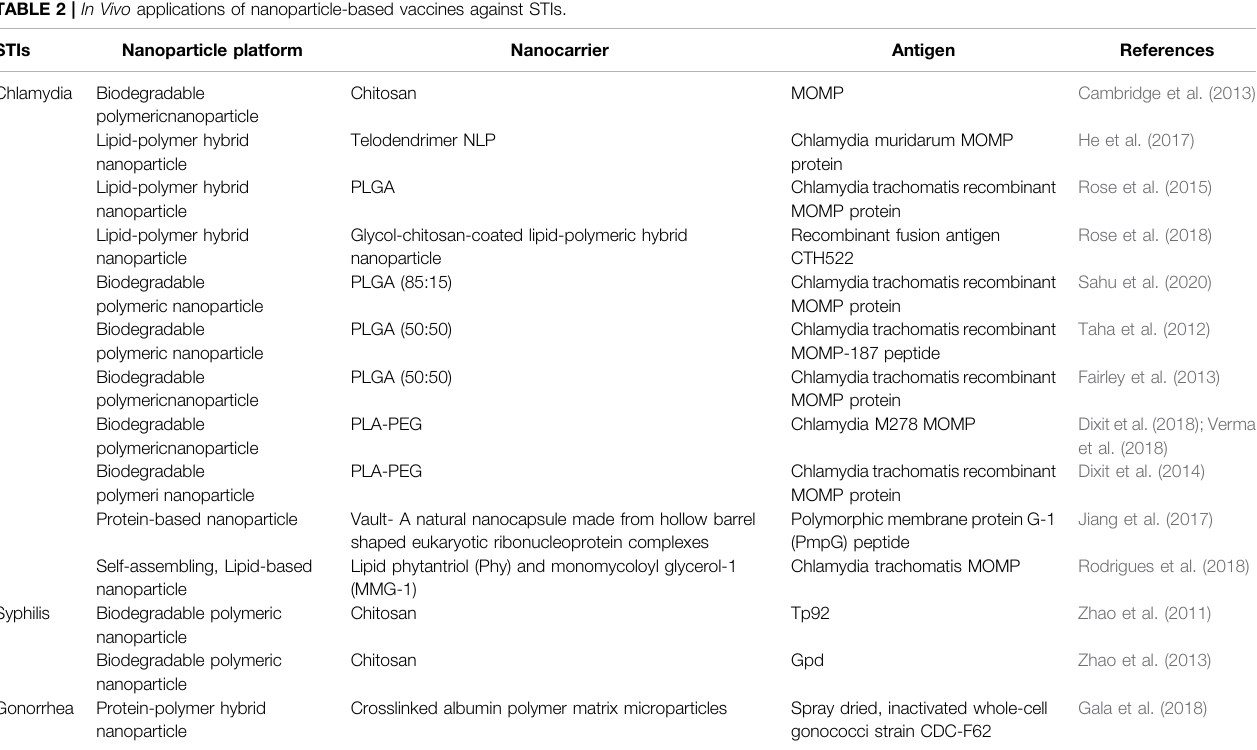
TABLE 2 | In Vivo applications of nanoparticle-based vaccines against STIs.